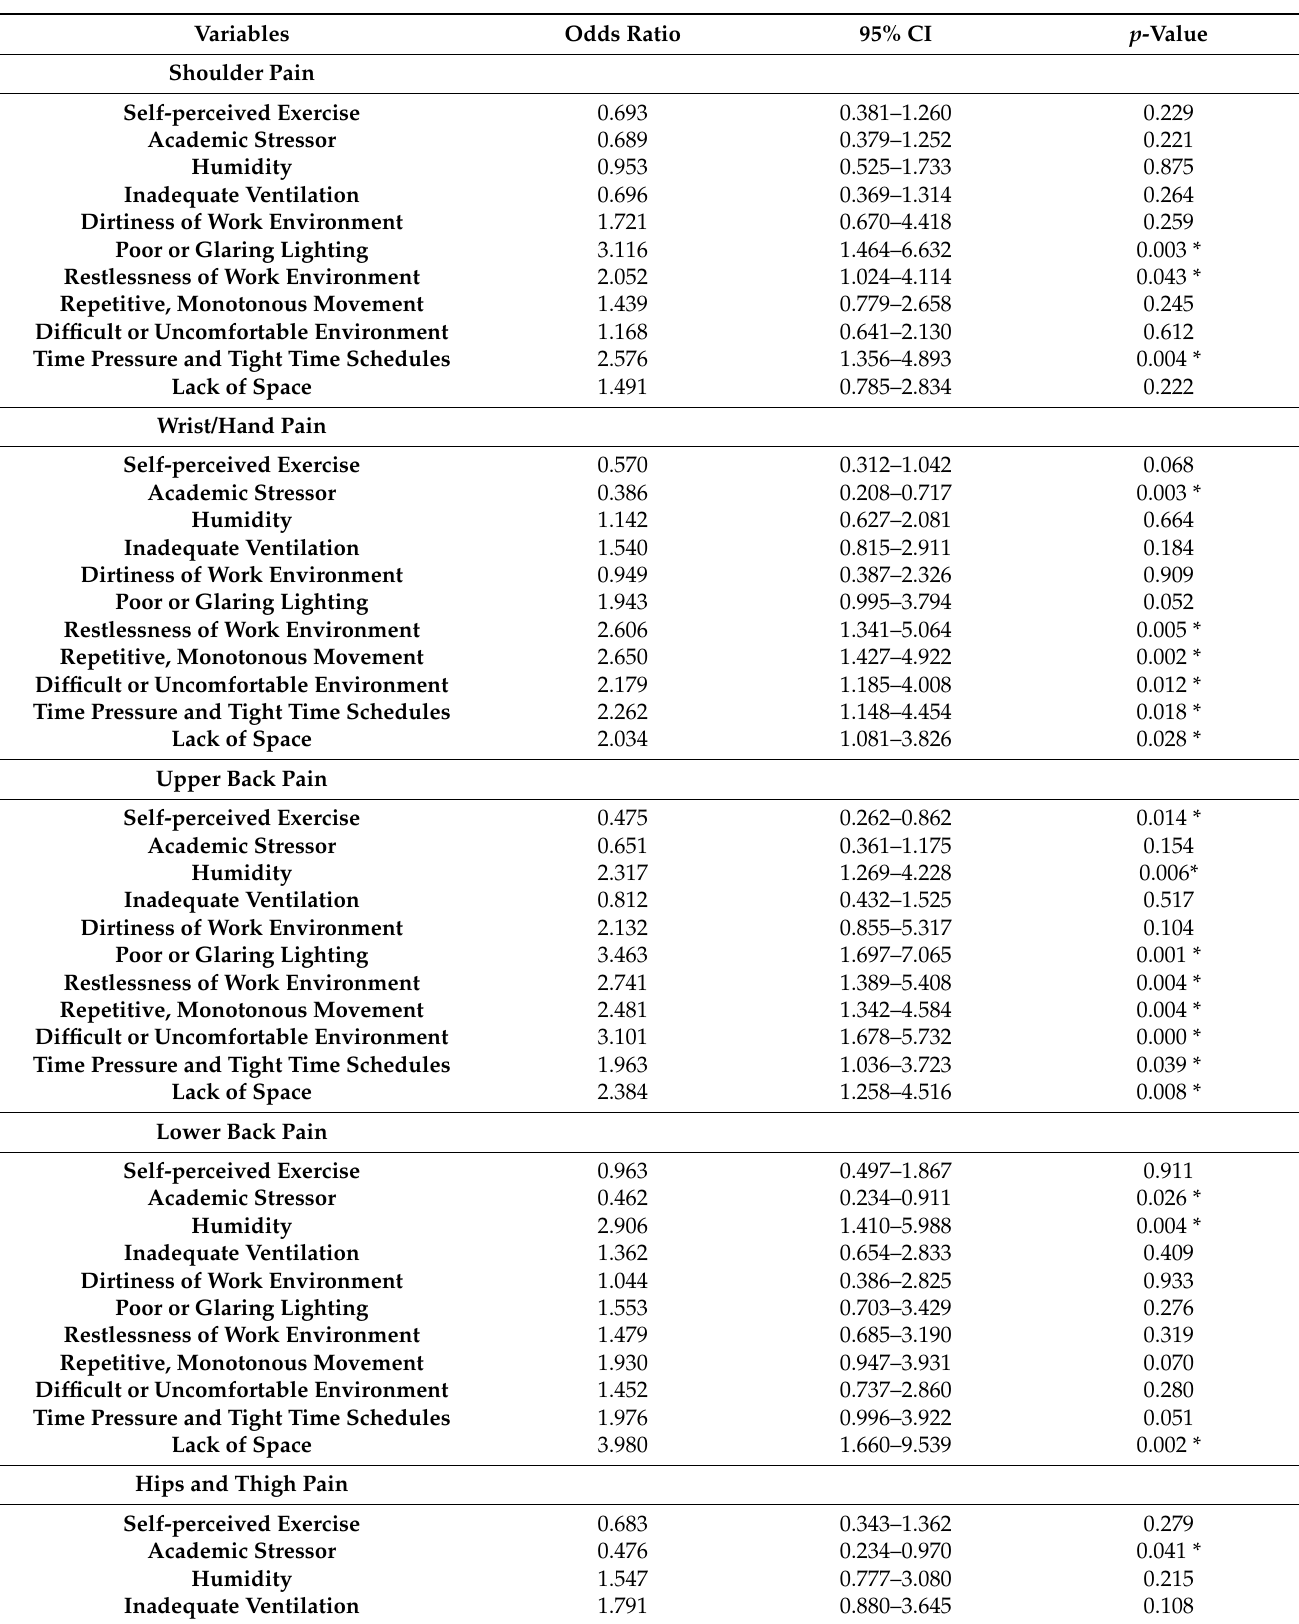
Table 2. Association between musculoskeletal pain (body part) with personal, academic stressors and environment